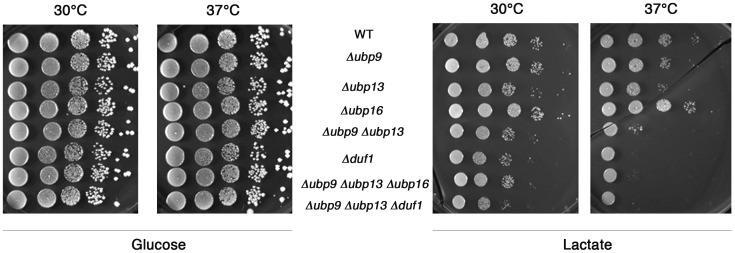
Δubp9 Δubp13 and Δduf1 mutants have a similar respiratory phenotype, which is not aggravated by the deletion of UBP16.Dilution series of wild-type BY4741 (WT), Δubp9, Δubp13, Δubp16, Δubp9 Δubp13, Δduf1, Δubp9 Δubp13 Δubp16 and Δubp9 Δubp13 Δduf1 strains were grown on medium containing fermentable (glucose) or respiratory (lactate) substrates for 5 days at 30°C and 37°C.